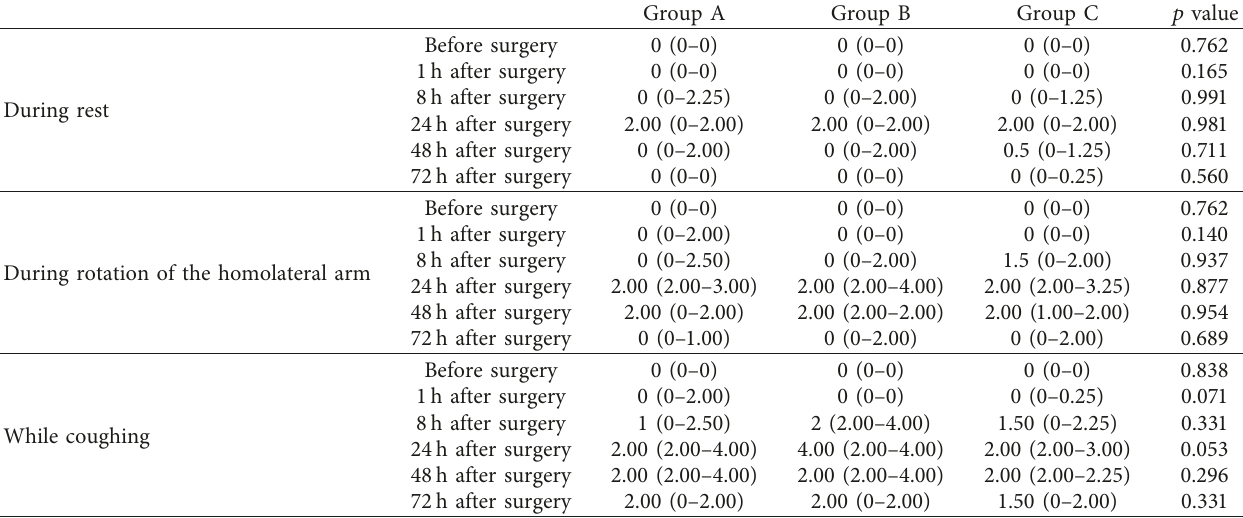
Table 2: Comparison of VAS in the 72h postoperative period among the three groups.